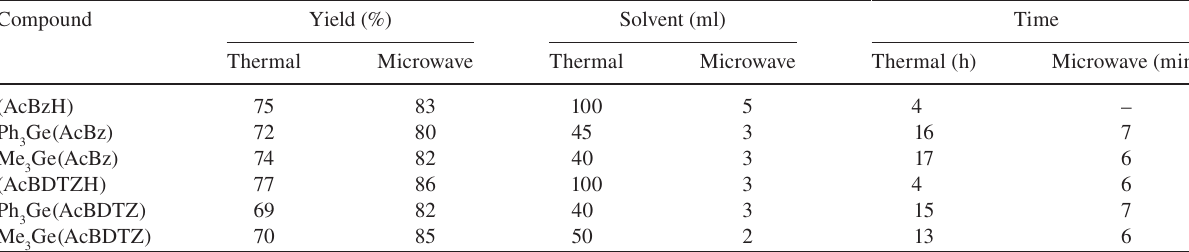
Table 4 Comparison between microwave and thermal